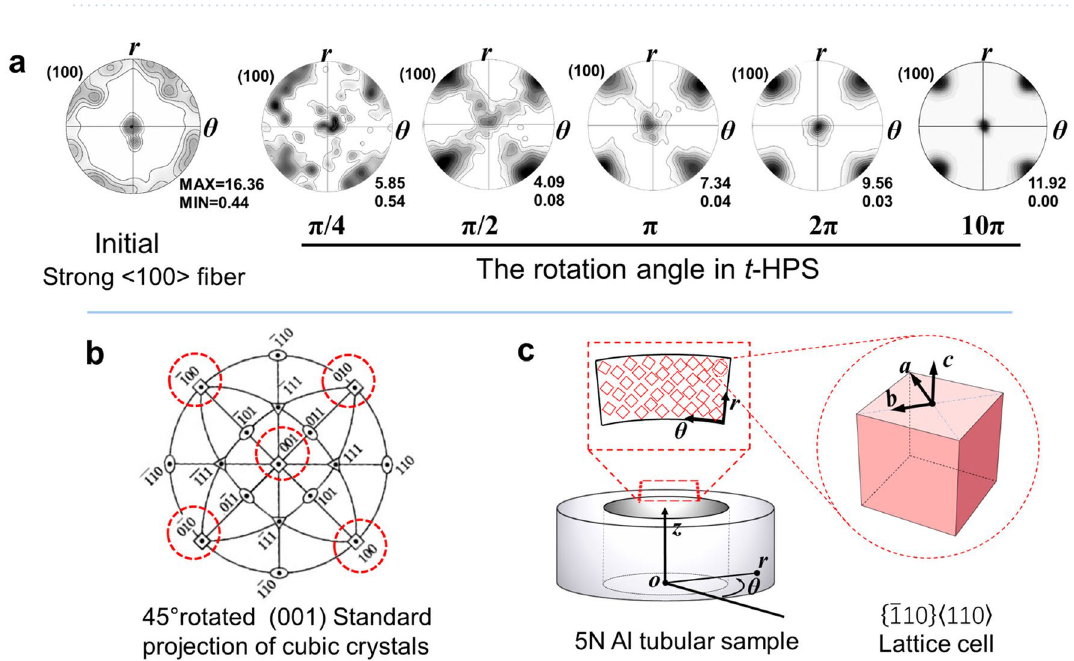
Figure 6. ( a ) (100) pole figures of the as-received 5N Al sample bar and after t -HPS processing; ( b ) 45° rotated (001) standard projection of cubic crystal and ( c ) the illustration of an ideal { relation to the t -HPS tube